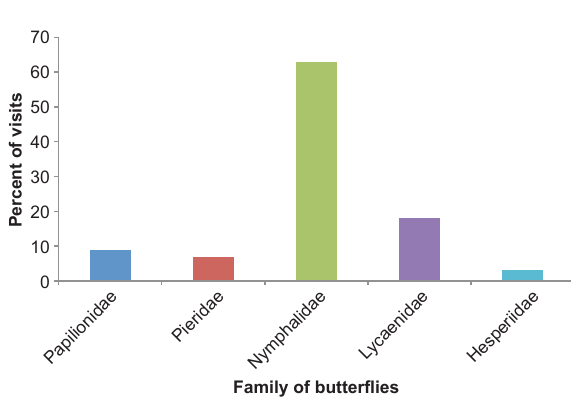
Figure 2: Family-wise percentage of foraging visits of butterflies on Wendlandia tinctoria